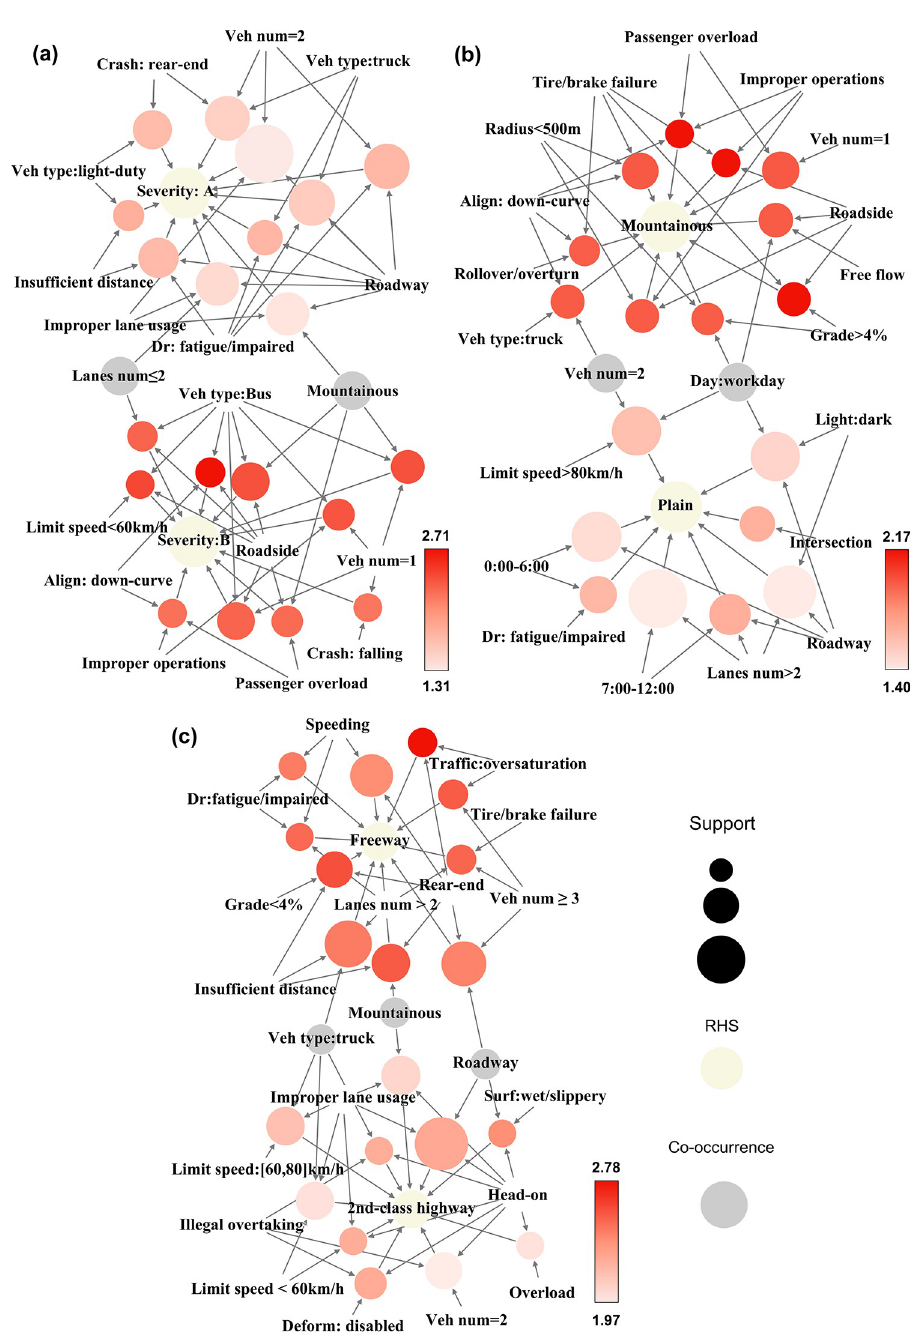
Fig 5. Graph structure for specific rule set. (a) Severity: A & Severity: B, (b) Mountainous & Plain (terrain), and (c) Freeway & 2nd-class highway (road category). location, mountain terrain, and truck crashes are the co-occurrence items of these two groups. According to the frequency in Fig 5(C), the patterns related to freeways include rear-end, mul- tiple-vehicle collision, speeding, insufficient distance, and fatigued driving. Moreover, the characteristics of 2nd-class highways include head-on crashes, driving on the wrong side, truck accidents, and illegal overtaking. The collision type (rear-end and head-on) is the most